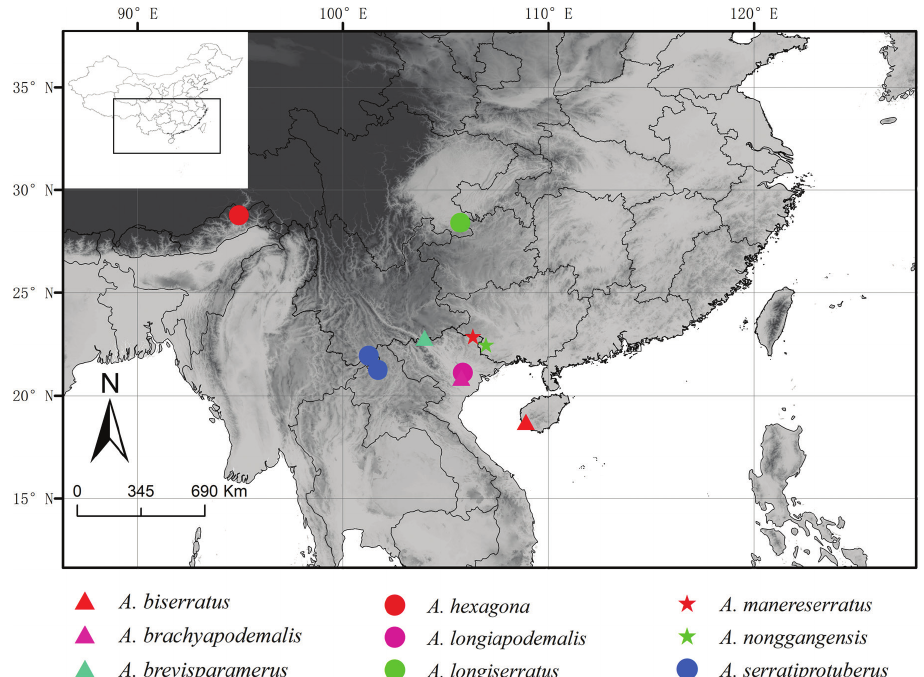
Figure 1. Known distribution of Anaxiphomorpha species, including the new species A. nonggangensis sp. nov. and A. manereserratus sp.